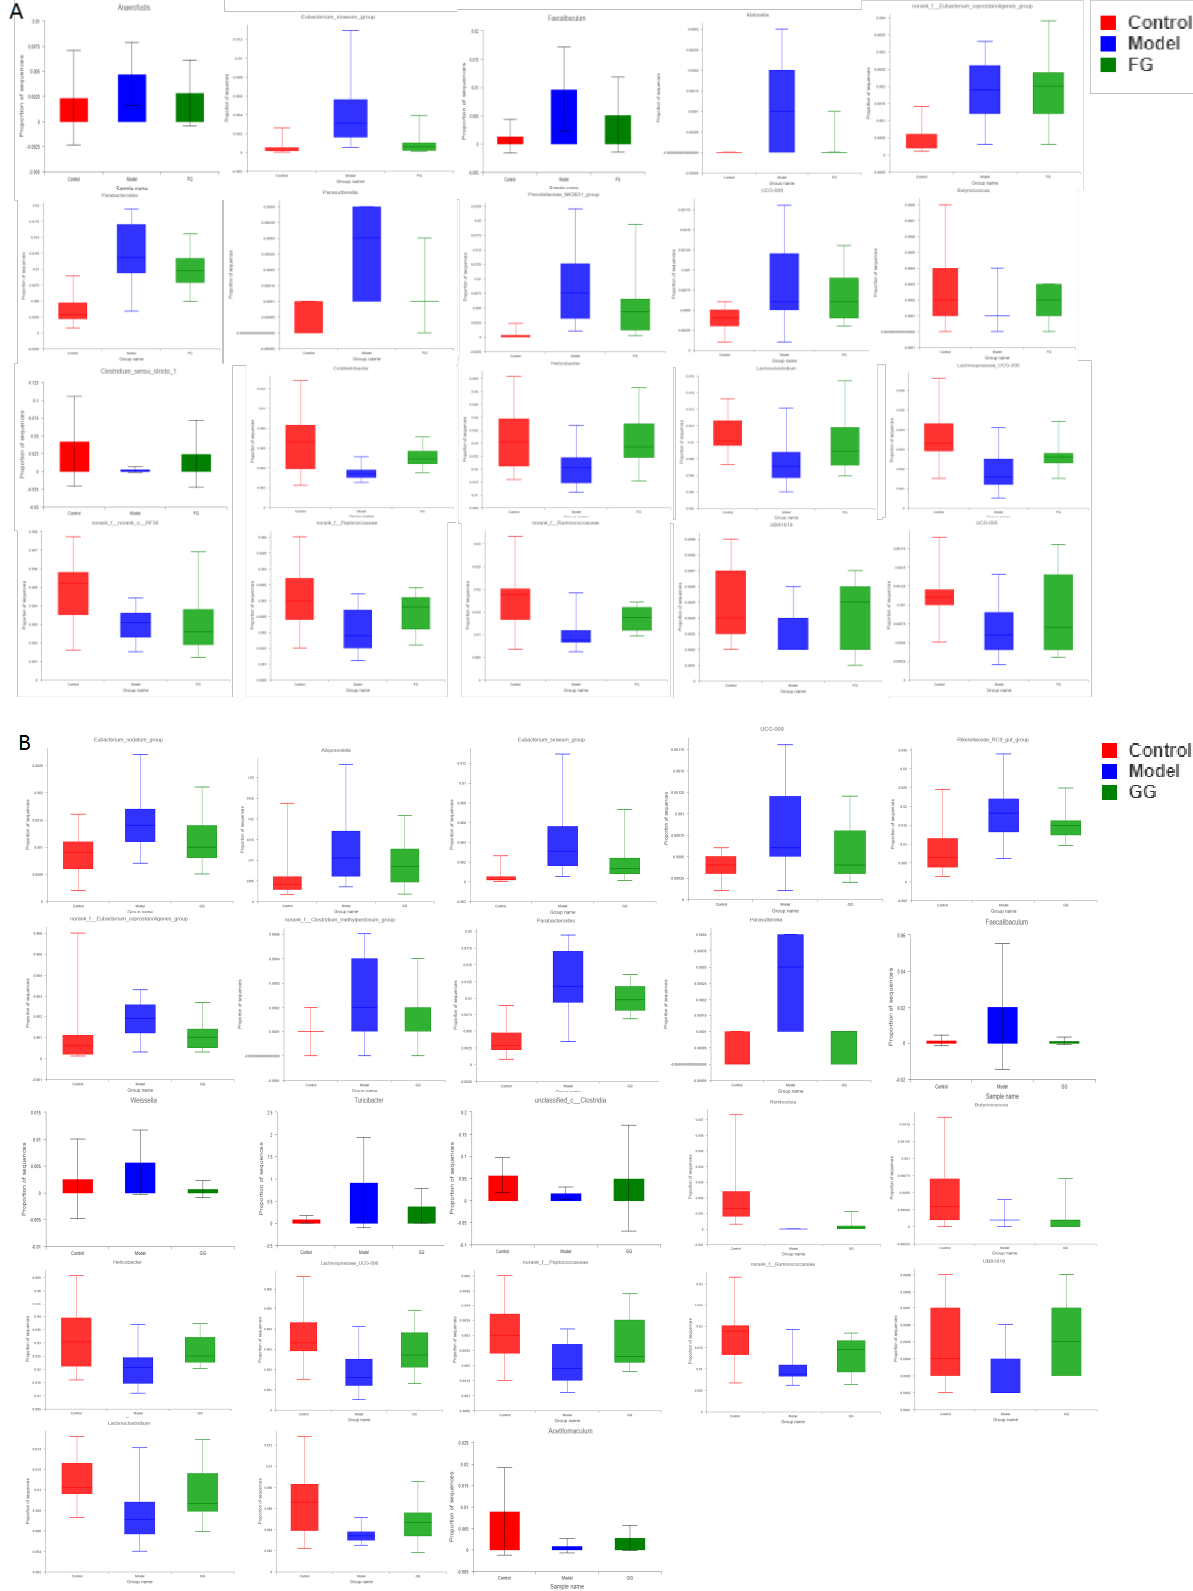
Figure 16. Effects of Pueraria polysaccharide on the cecal microflora in db/db mice (( A ). FG; ( B ).